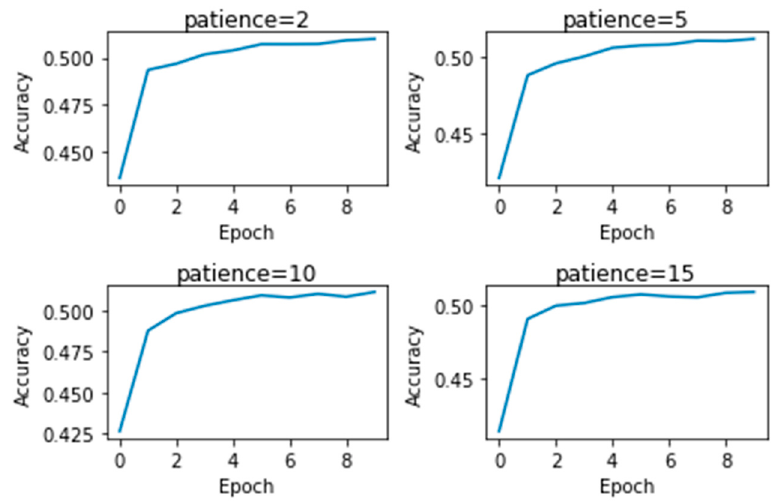
ff ect of patience value on RNN. Figure 4. Effect of patience value on RNN. Figure 4. E